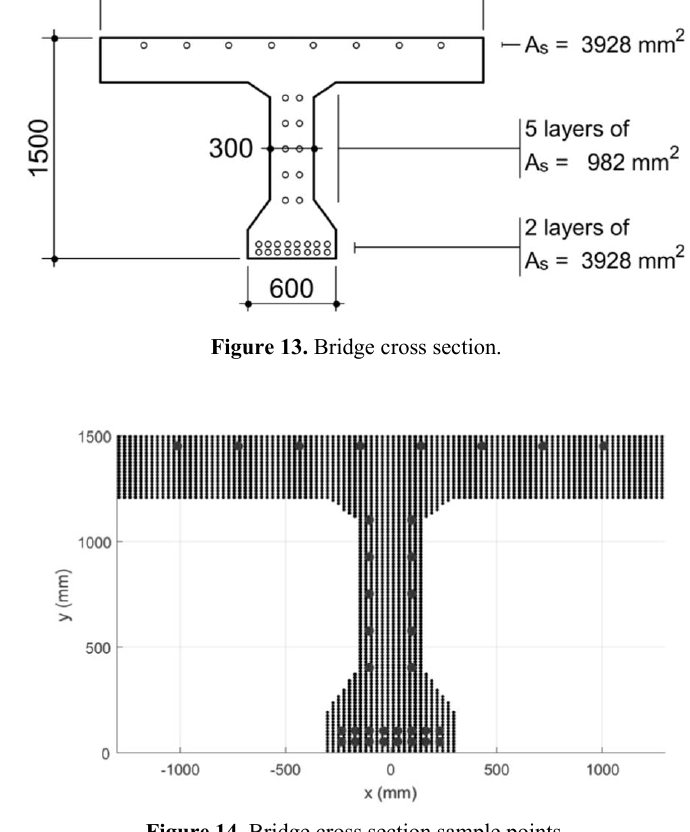
Figure 14. Bridge cross section sample points.